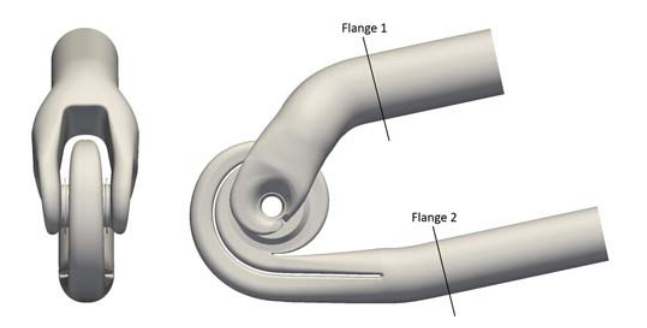
Figure 1. Front and side view of the CAD representing the centrifugal pump, areas of the Flange 1 and 2 equal to 0.02840 and 0.01941 m 2 , respectively.